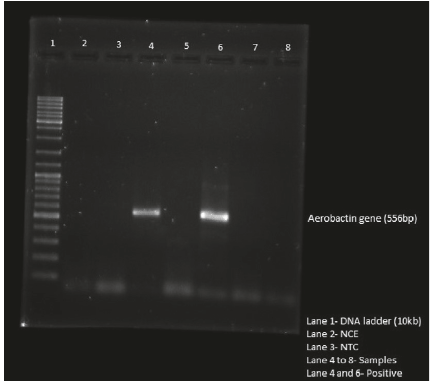
Non − MDR–Resistant to ≤ 2 classes of antibiotics; MDR—resistant to ≥ 3 classes of antibiotics; ESBL+—ESBL producers; ∗ Incidence higher (statis- tically significant) when compared to non − MDR